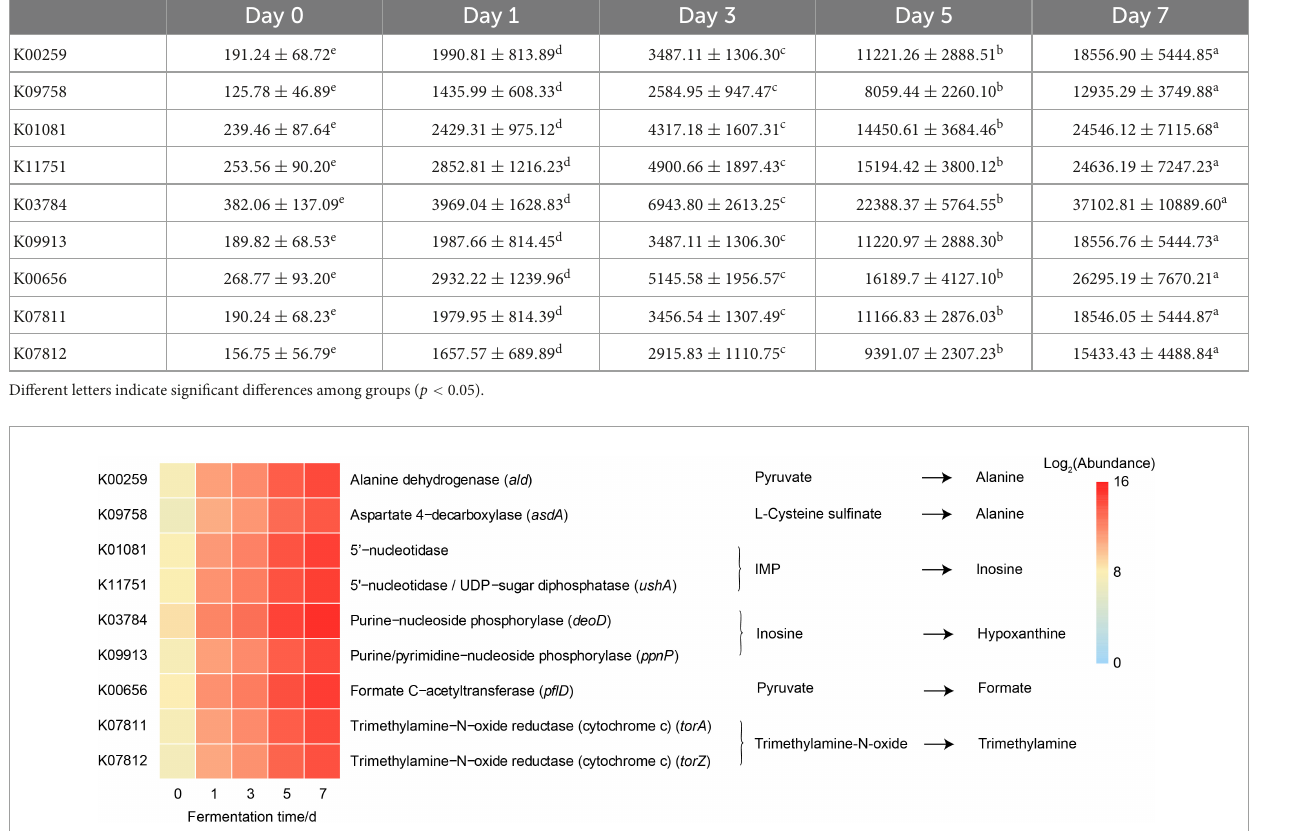
FIGURE5 Heatmap showing the abundances of predicted function genes of Vibrio involved in the metabolic pathways of significantly changed metabolites of crab paste during fermentation. The data of gene abundances were log2